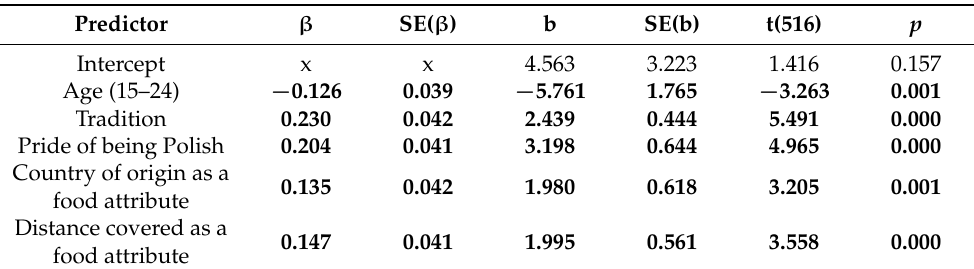
Table 10. Selected predictors of consumer ethnocentrism in the food market among women (a retrograde stepwise regression